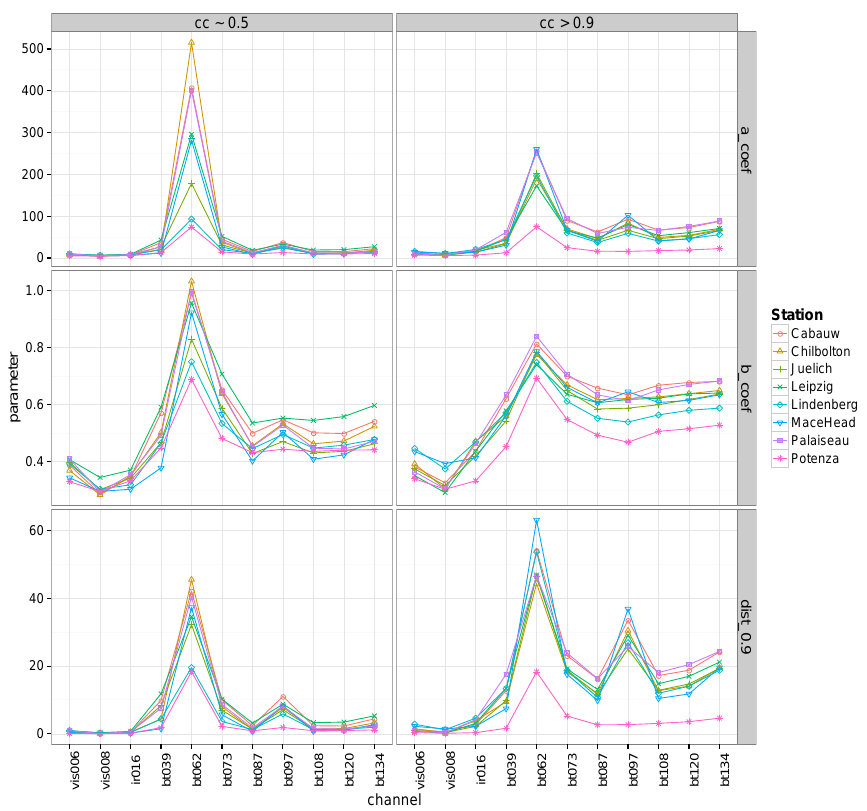
Figure 6. Comparison of coefficients a (upper panel) and b (middle panel) as well as dist 0 . 9 (lower panel) for two different cloud covers (left side: half covered scenes; right side: fully covered scenes) and for all channels ( x axes) and locations (different colours, see